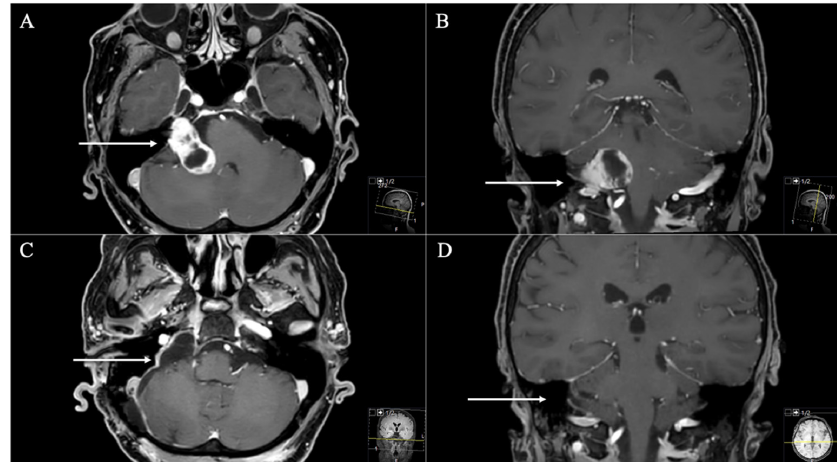
Figure 1. A 66-year-old female patient presenting with headache, vertigo, and cerebellar dysfunction. ( A ) Preoperative axial and ( B ) coronal T1-weighted gadolinium-enhanced MRI, displaying cystic JFS (arrows), involving the CPA (Samii Type A). ( C ) Postoperative axial and ( D ) coronal MRI control, indicating complete resection (arrows) through a classic retrosigmoid approach. Postoperatively, mild facial nerve palsy (House and Brackmann II) occurred and remained during follow-up.